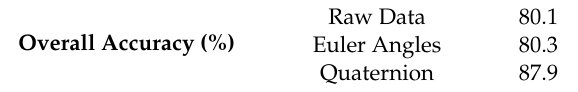
Table 4. Recognition accuracy with raw data, Euler angles, and quaternion in the case of lower back